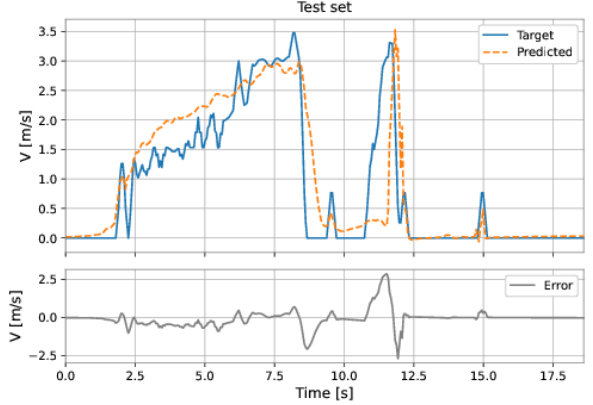
Figure 49. MLP-TDNN’s predictions on the training set.